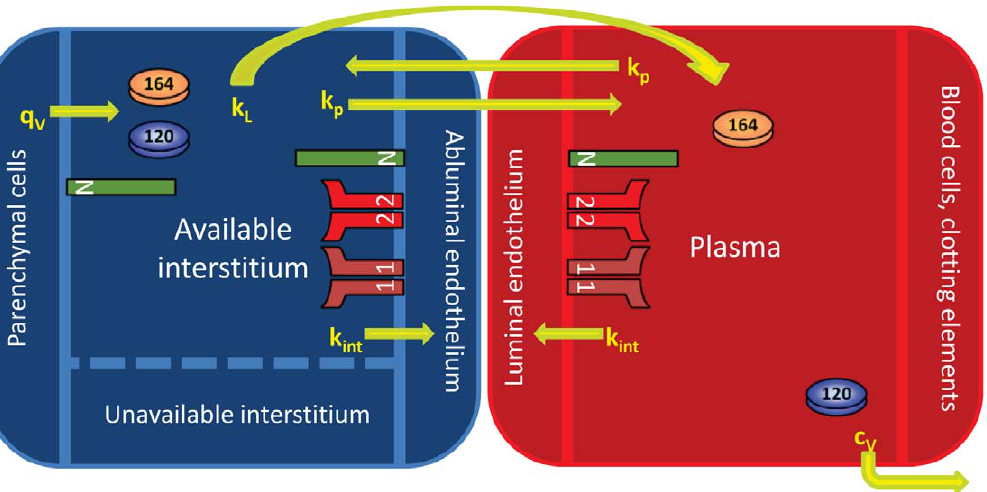
Figure 1. Two compartment model. The model is divided into the tissue and blood compartments. VEGF 120 and VEGF 164 - are secreted by the parenchymal cells (myocytes) into the available interstitial space at rate q v . VEGFR-1, VEGFR-2 and NRP-1 are localized on the luminal and abluminal surfaces of the endothelial cells. NRP-1 is also found on the myocyte cell surface. Inter-compartmental transport includes lymphatic drainage ( k L ) and microvascular permeability ( k- p ). Receptors and VEGF/receptor complexes on endothelial cells and myocytes can be internalized ( k int ). VEGF is removed from the blood compartment via plasma clearance ( c v ).